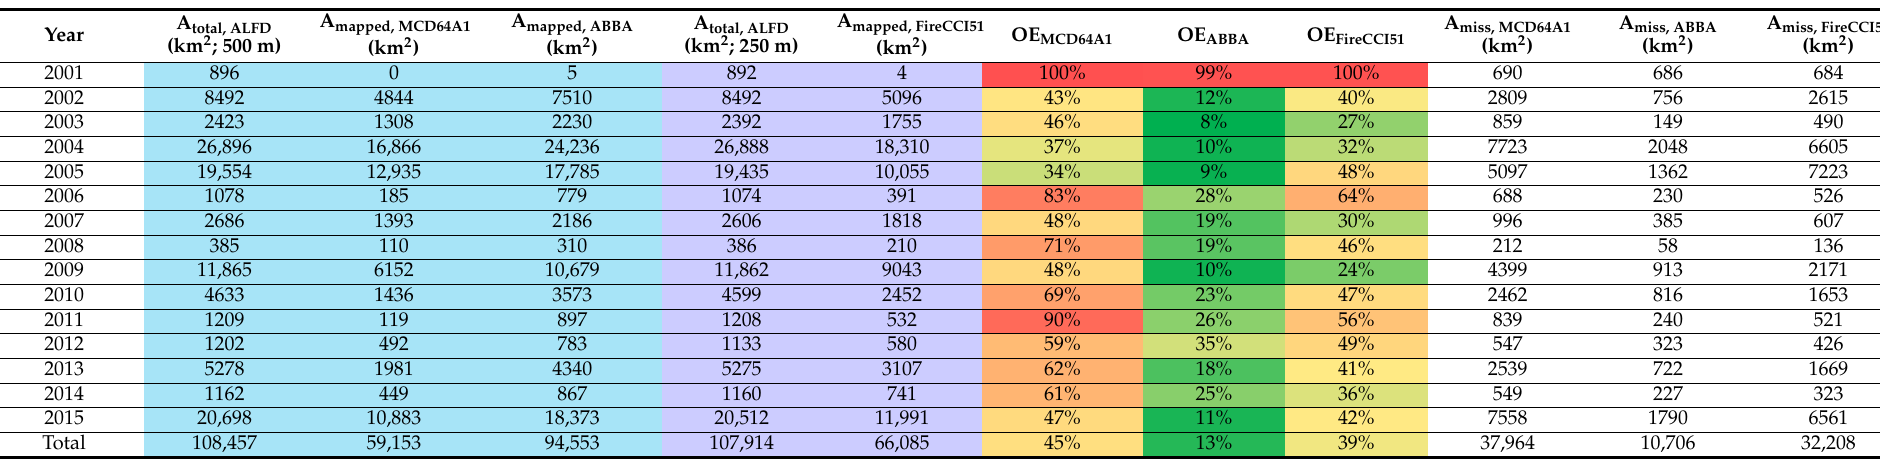
Table 3. Results of the omission error analysis that was based on the ALFD dataset in Alaska. The cells that are highlighted in blue and purple represent the comparisons made at the 500 m and 250 m nominal resolutions, respectively. The cells that contain OE values are colored, with green to red indicating low to high OE values.